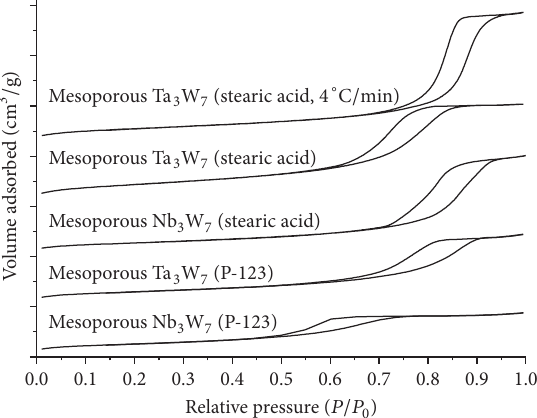
Figure 5: N 2 adsorption-desorption isotherms of mesoporous Nb 3 W 7 oxide (P-123), mesoporous Ta 3 W 7 oxide (P-123), meso- porous Nb 3 W 7 oxide (stearic acid), mesoporous Ta 3 W 7 oxide (stearic acid), and mesoporous Ta 3 W 7 oxide (stearic acid, 4 ∘